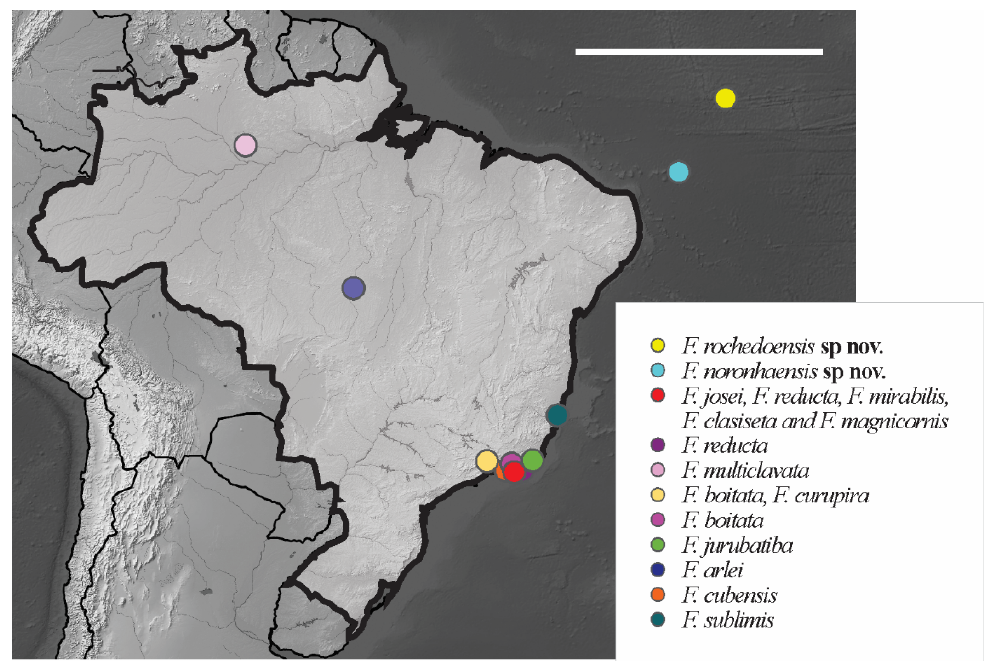
Figure 11. Distribution map for Brazilian species of the genus Friesea Dalla Torre, 1895. Scale bar: 3000 km.